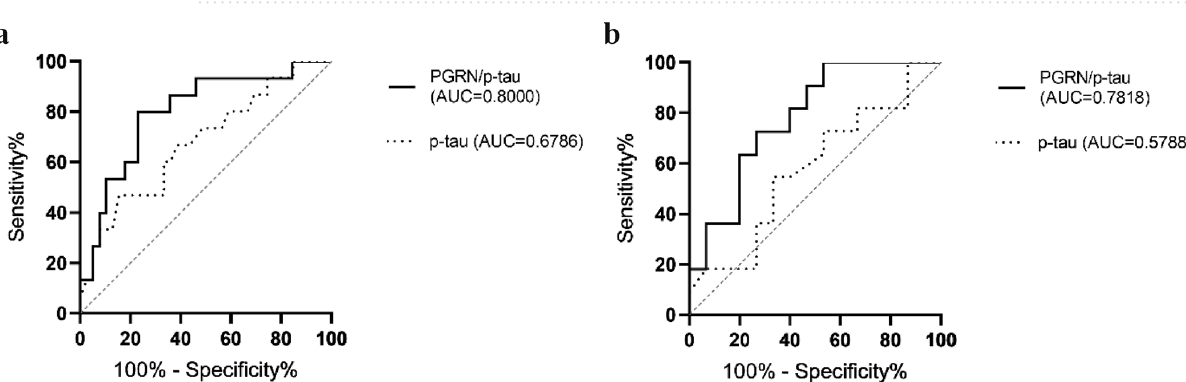
Figure 3. ROC diagrams of the TDP-43/Aβ42 ratio (solid line) and Aβ42 values (dotted line) in ( a ) AD vs. non-AD disease cases: for the TDP-43/Aβ42 ratio AUC 0.8695, CI 0.806 to 0.933, cut-off 6.737, p < 0.0001, for Aβ42 AUC 0.7840, CI 0.692 to 0.876, cut-off 425.5 pg/ml, p < 0.0001, ( b ) prion diseases vs. FTLD-TDP: for the TDP-43/Aβ42 ratio AUC 0.8072, CI 0.671 to 0.943, cut-off 9.537, p = 0.0006, for Aβ42 AUC 0.6036, CI 0.430 to 0.777, cut-off 867.0 pg/ml, p non-significant. TDP-43, TAR DNA binding protein-43; Aβ42, amyloid-beta (1–42); AD, Alzheimer disease; FTLD-TDP, frontotemporal lobar degeneration with TDP-43 inclusions; AUC, area under the curve; CI, 95% confidence interval.